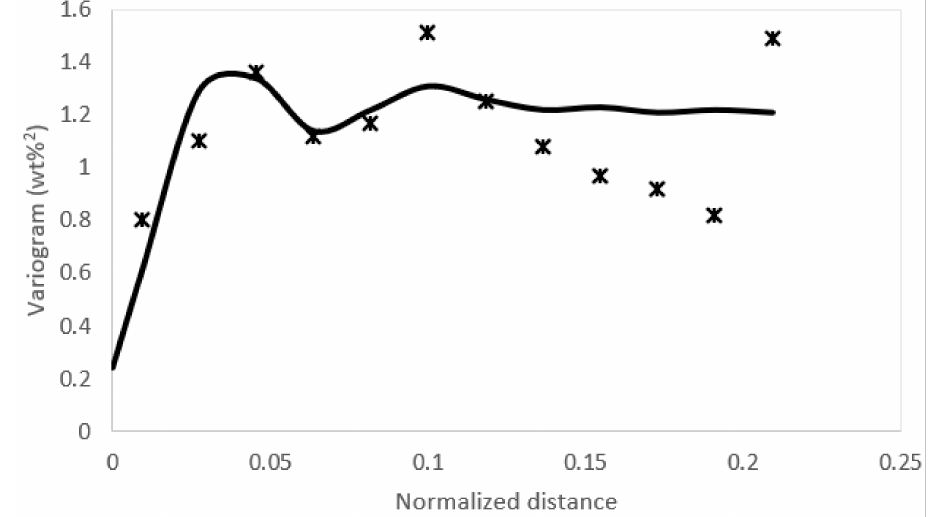
Figure 5. Theoretical variogram fitted on the experimental variogram of the measurements. Stars denote the experimental variogram and the continued black line the Spartan model fit.